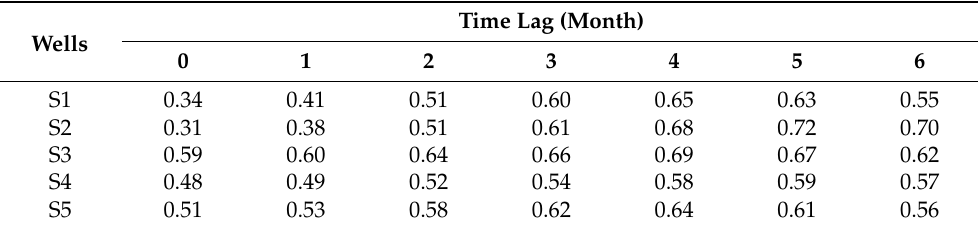
In order to quantify the agreement between GWFM-based GWSA and in